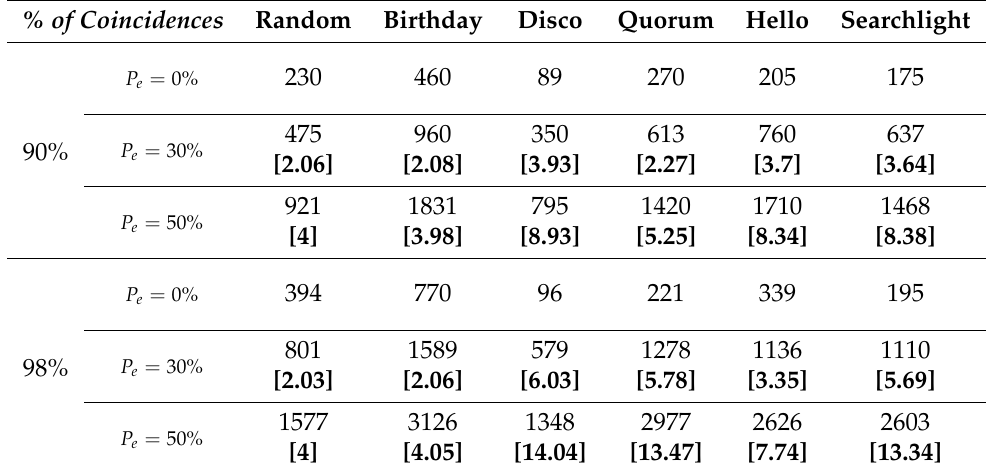
Table 3. Slots required to reach 90% and 98% of coincidences for 10% Duty Cycle. % of